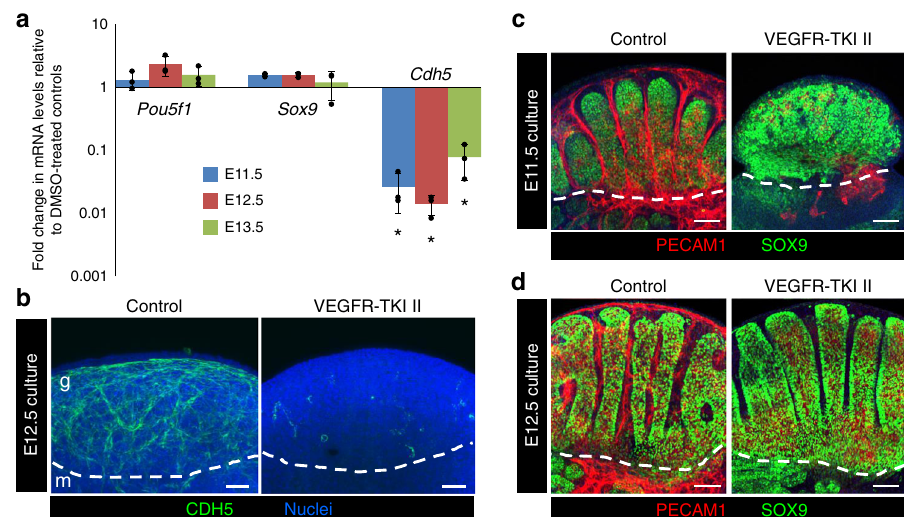
Fig. 1 Vasculature is dispensable for Sertoli cell differentiation. a qPCR analysis representing fold change in expression of Pou5f1 (also known as Oct4 ; germ cell gene), Sox9 (Sertoli cell gene), and Cdh5 (endothelial cell gene) in E11.5, E12.5, and E13.5 vascular-depleted fetal testes cultured for 48 h in the presence of VEGFR-TKI II (1.8 µ g/ µ l) compared to DMSO-treated controls. Data are presented as the mean ± SD of 3 independent biological replicates (n = 3 litters, ≥ 5 gonads/litter). * P < 0.05 (two-tailed Student t -test). b Immuno fl uorescence images of E12.5 fetal testes cultured in the presence or absence (control; DMSO) of VEGFR-TKI II for 48 h. Relative to controls, vascular-depleted gonads showed a severe reduction of CDH5 (endothelial cell marker) immunostaining. c , d Immuno fl uorescence images of E11.5 ( c ) and E12.5 ( d ) fetal testes cultured in the presence or absence of VEGFR-TKI II stained for PECAM1 (germ/endothelial cell marker) and SOX9 (Sertoli cell marker). Dashed lines throughout indicate the border between the gonad (g) and mesonephros (m). Scale bars, 100 μ